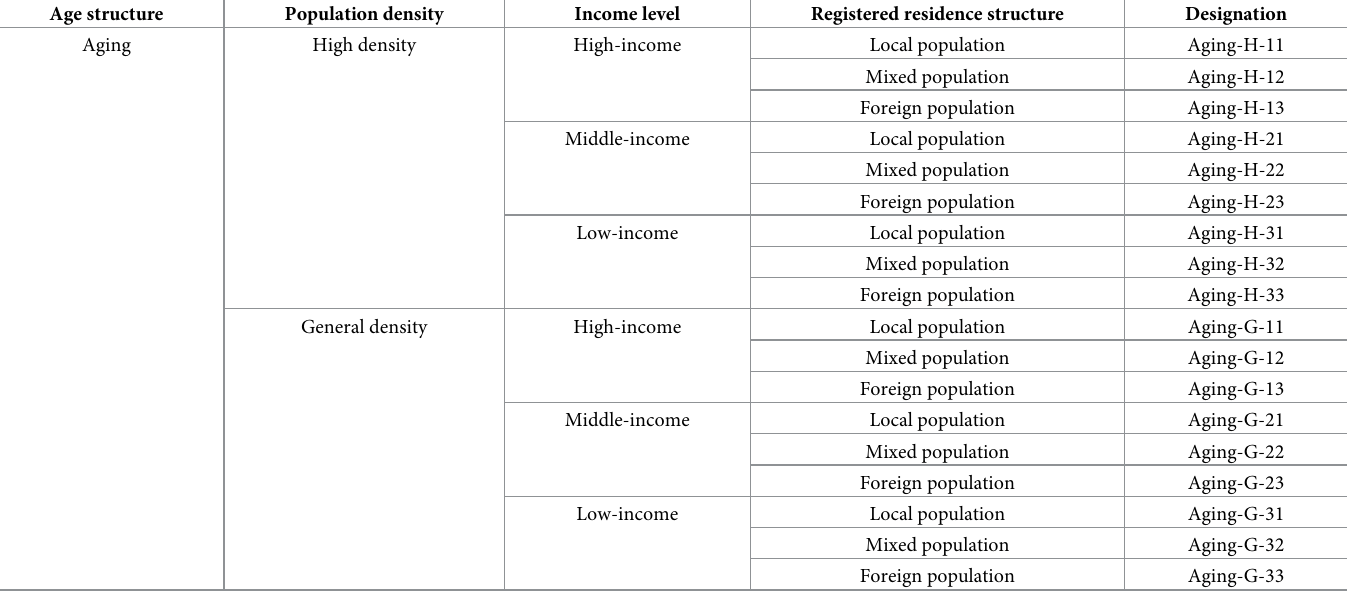
Table 3. Community types and designations in